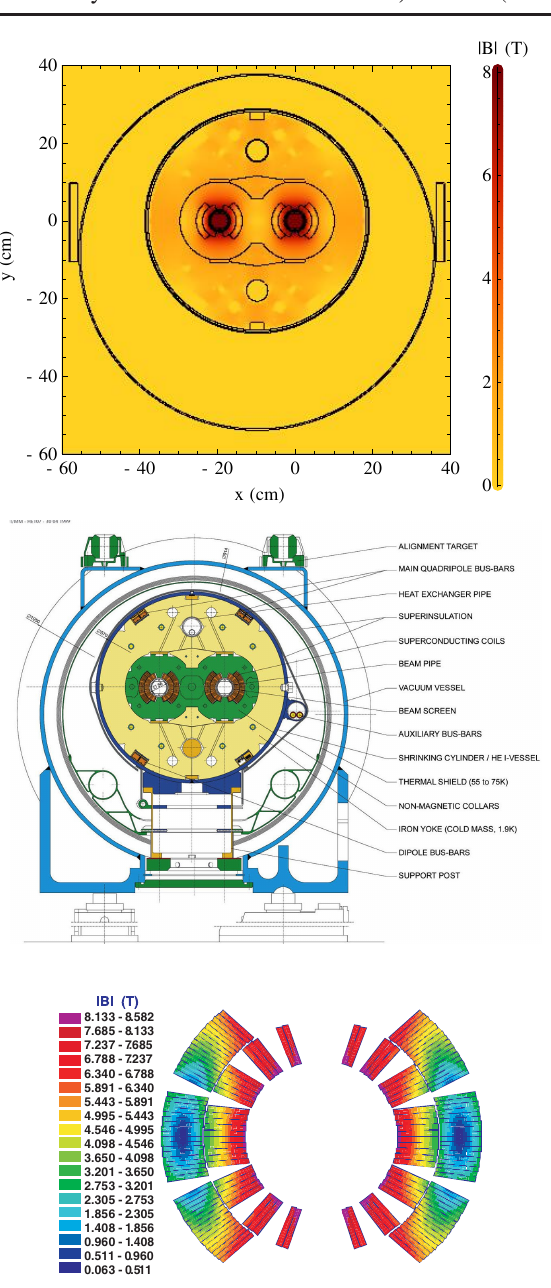
FIG. 6. (Color) The transverse cross section of the FLUKA model with the magnetic field superimposed (top), a technical drawing [1] (bottom) of an LHC main dipole (middle) and the magnetic field in the superconducting cables (bottom). The rectangular boxes on the outside of the magnet in the FLUKA model represent beam-loss monitors as discussed in Sec.